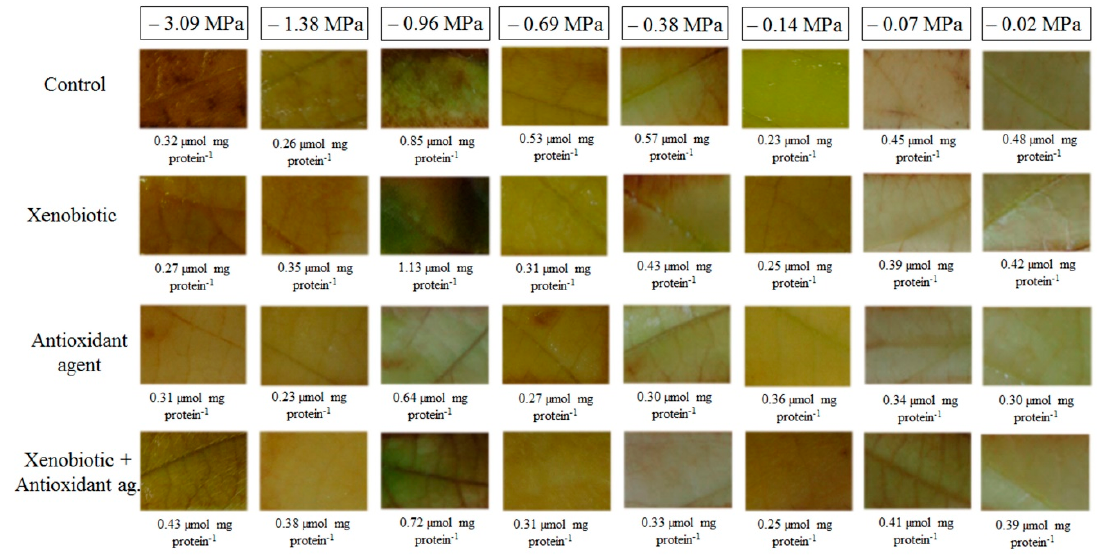
Figure 5. In situ detection of hydrogen peroxide in soybean plants under different soil water potentials and xenobiotic and antioxidant agent applications.